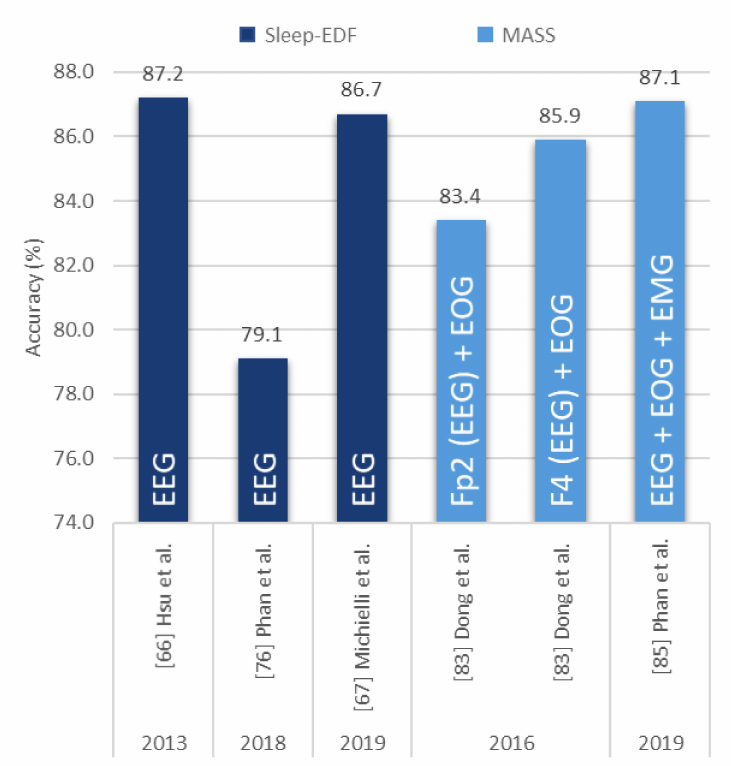
Figure 12. Sleep stage classification accuracy of RNN / LSTM-based models based on stand-alone EEG signals or a mixture of EEG, EOG, and ECG signals. Various sleep datasets are represented by di ff erent colors and the type of signals described in the bar chart. * Summary statistics: Using RNN versus LSTM models for EEG / EEG + other signals from